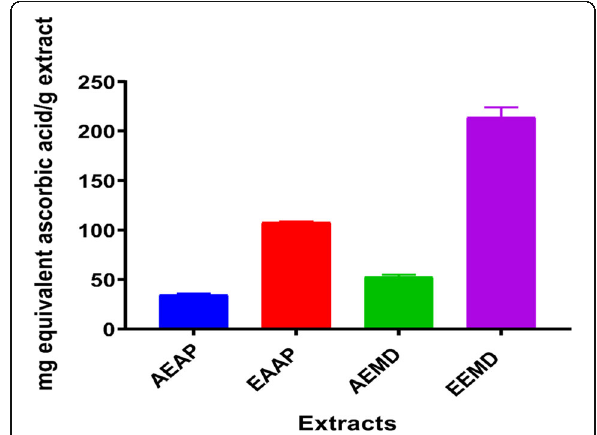
Fig. 3 Total antioxidant capacity of the extracts. The values are presented as mean ± SD, ( n = 3)